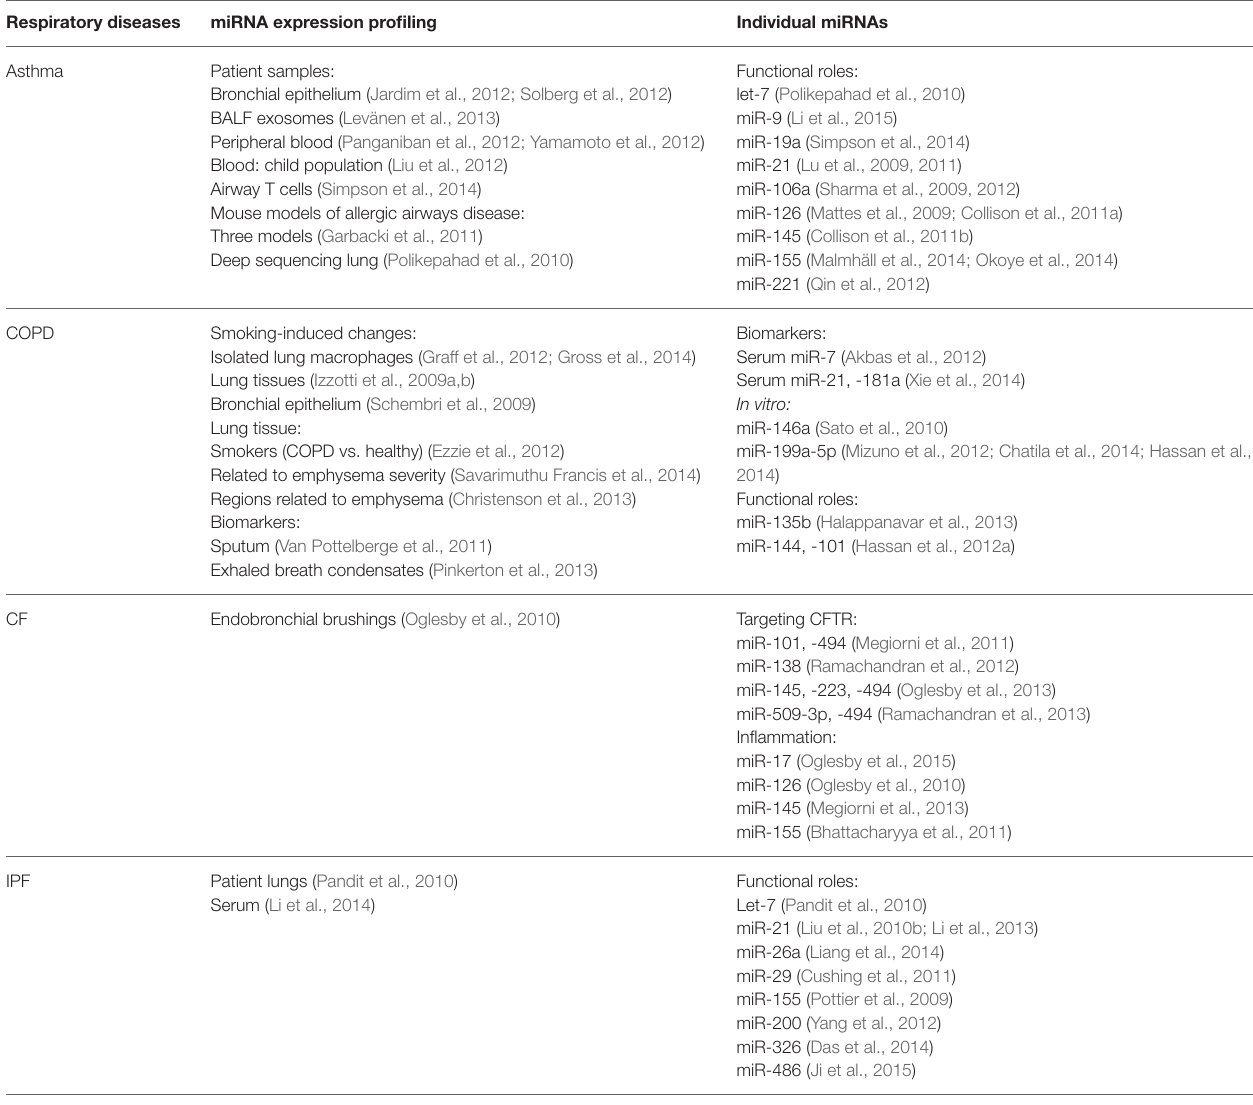
TABLE 1 | MicroRNA profiling studies and individual microRNAs identified in respiratory diseases. Respiratory